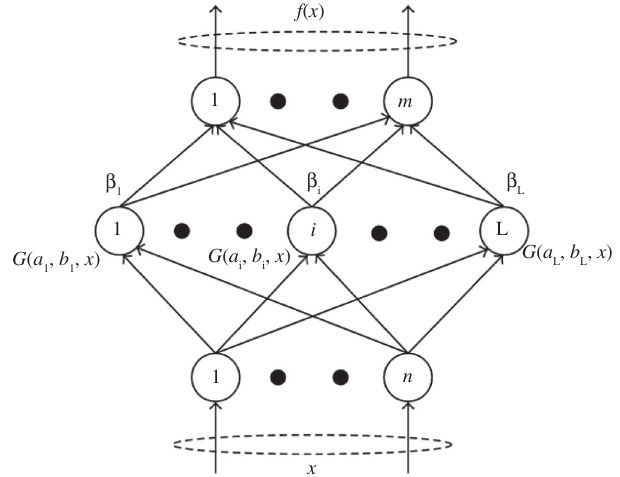
Figure 1: Illustration of the ELM Structure